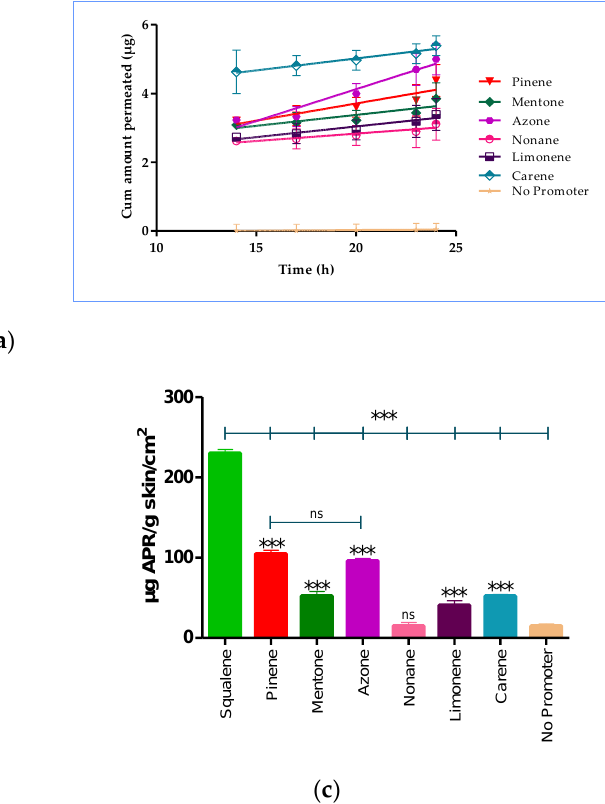
Table 7. Biopharmaceutical parameters of Apremilast-solutions with and without penetration en- hancer .